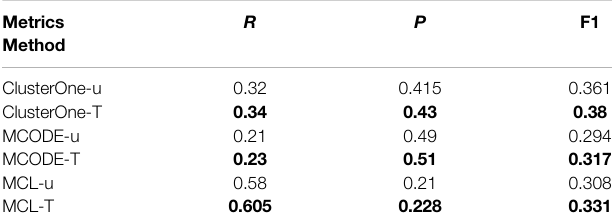
TABLE1| Resultsofmethodsareusedintheunweightednetworksandweighted networks computed by the TSSN. Metrics